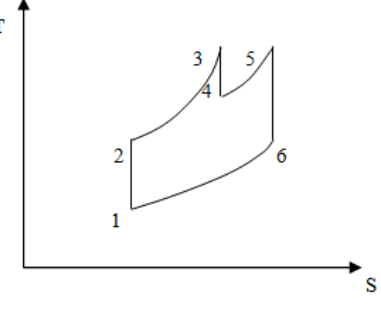
Figure 5. T-S chart of the reheat Brayton